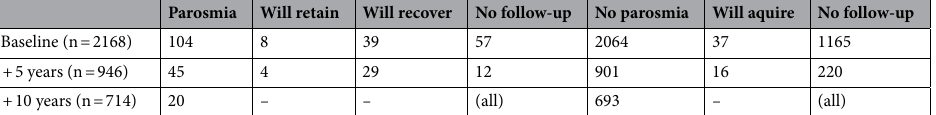
Table 3. Number of participants with and without parosmia at each test-wave, and their parosmia status at the following test-wave. Will retain parosmics who will retain their parosmia at the next testing occasion, Will recover parosmics who will recover at the next testing occasion, Will aquire non-parosmics who will aquire parosmia by the next testing occasion, No follow-up participants who were not involved in future testing. Note that at 10-year testing, further follow-up data is not